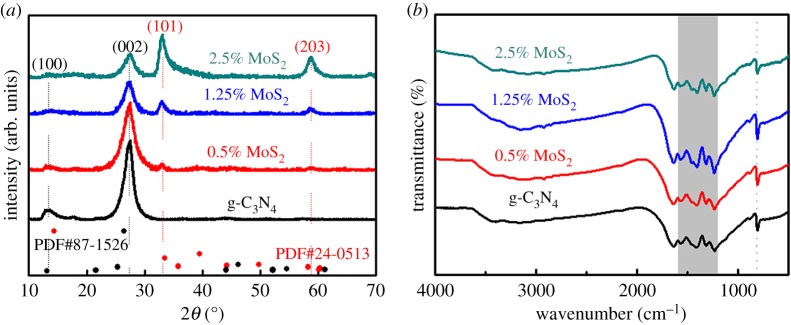
(a) XRD patterns and (b) FTIR spectra of g-C3N4, g-C3N4/0.5% MoS2, g-C3N4/1.25% MoS2 and g-C3N4/2.5% MoS2.